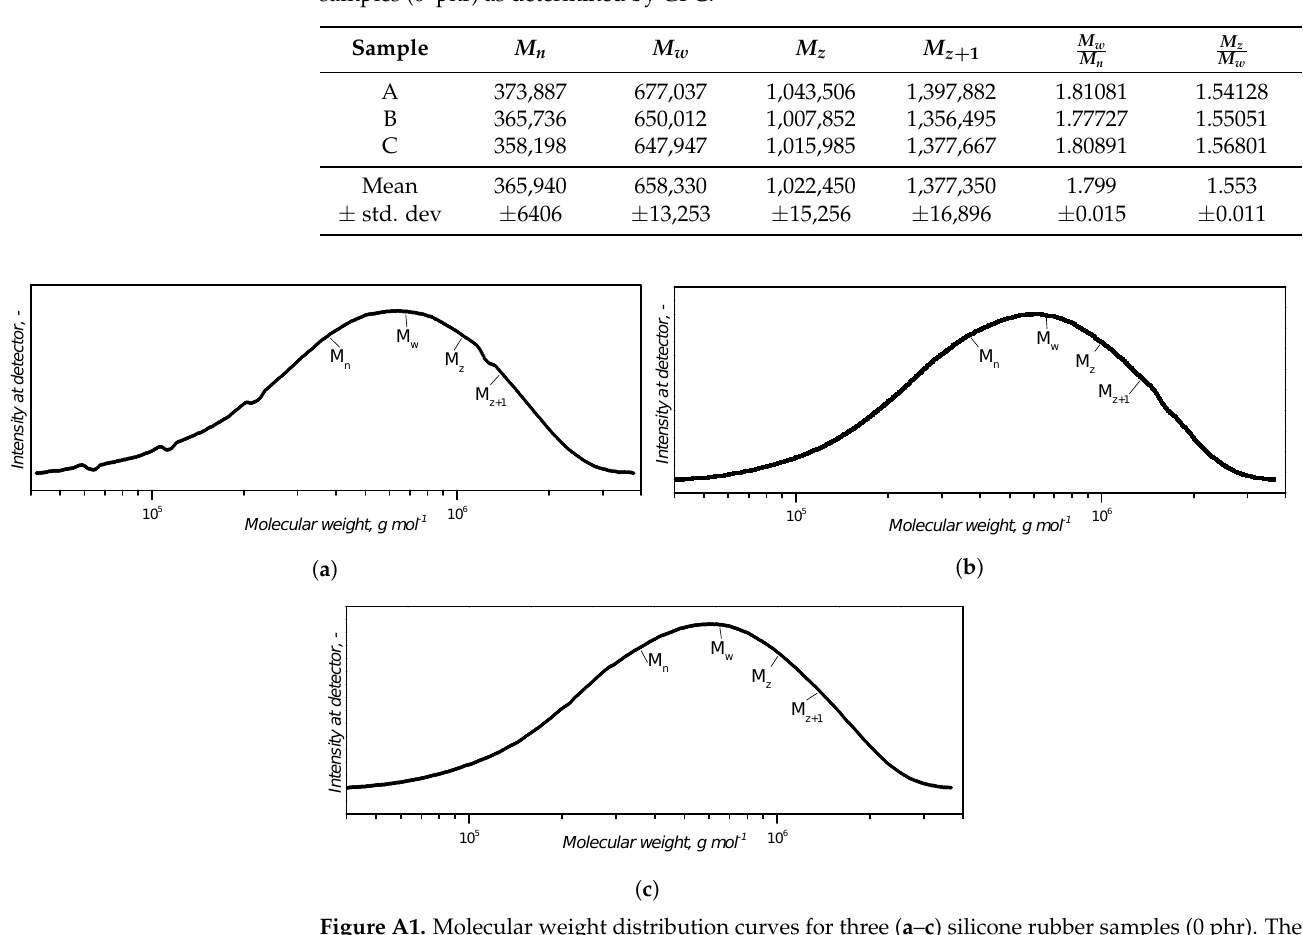
Figure A1. Molecular weight distribution curves for three ( a – c ) silicone rubber samples (0 phr). The notations along the curves are, from left to right, the number average, the weight average, and the higher average molecular